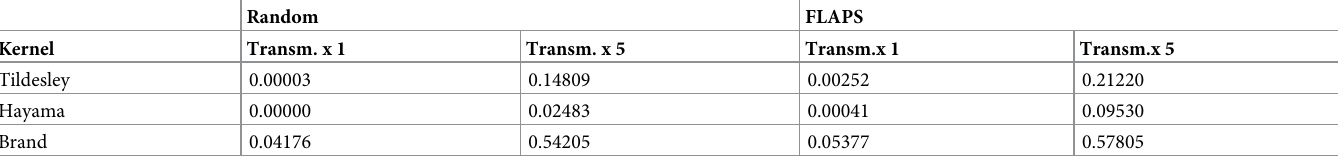
Table 1. The proportion of simulated outbreaks that reached 100 infected premises. Each combination of kernel, transmissibility scale factor and spatial premises dis- tribution is based on 30,490,000 seeded outbreaks. Random FLAPS Kernel Transm. x